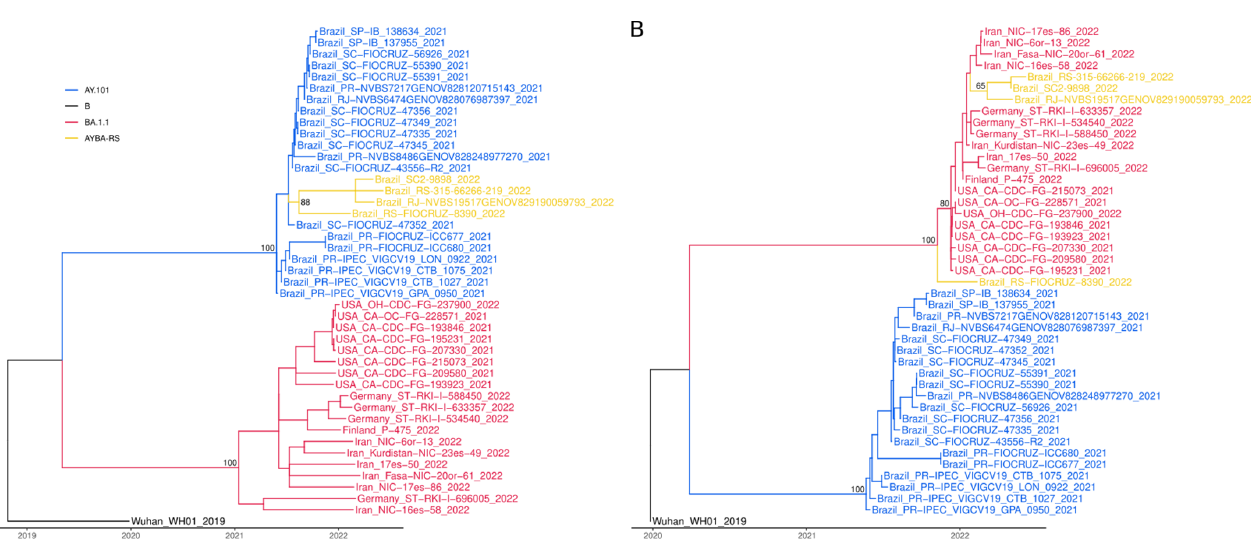
Figure A4. Nucleotide assignatures of each lineage. Heatmap showing the frequency of nucleotide mutations in each lineage. We utilized the blastn top-hits sequences for each parental lineage AY.101 (n = 20) and BA.1.1 (n = 19). Mutation frequencies of AYBA-RS were computed from the four sequences found in Brazil. Asterisk—exclusive mutation of AYBA-RS.